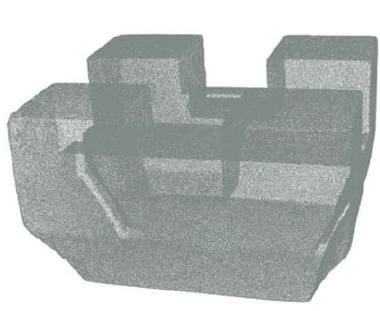
Figure 10. Point cloud of validation object.